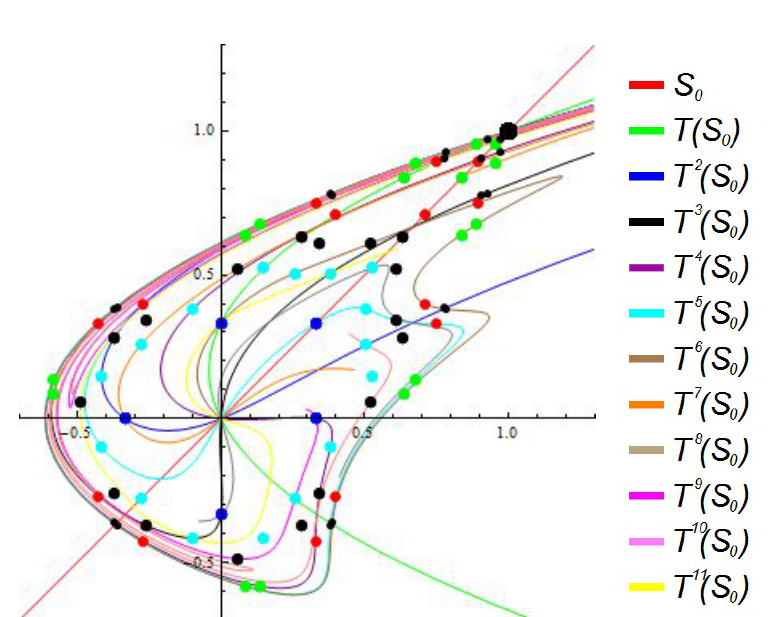
Figure 8. Possible orbit (P.O.) of period 5—Blue, 14—Red, 16—Cyan and Green, 17 and 18—Black for α = 0.5.